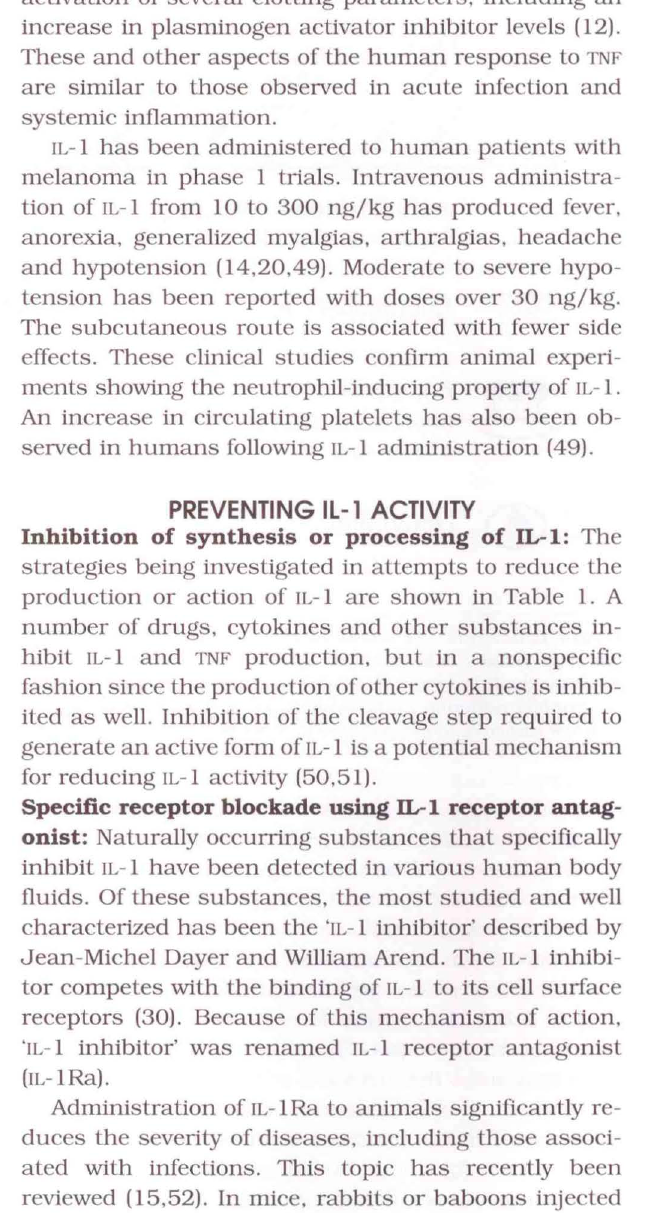
Strategies for reducing the effects of IL-1 in disease Substance Nonspecific